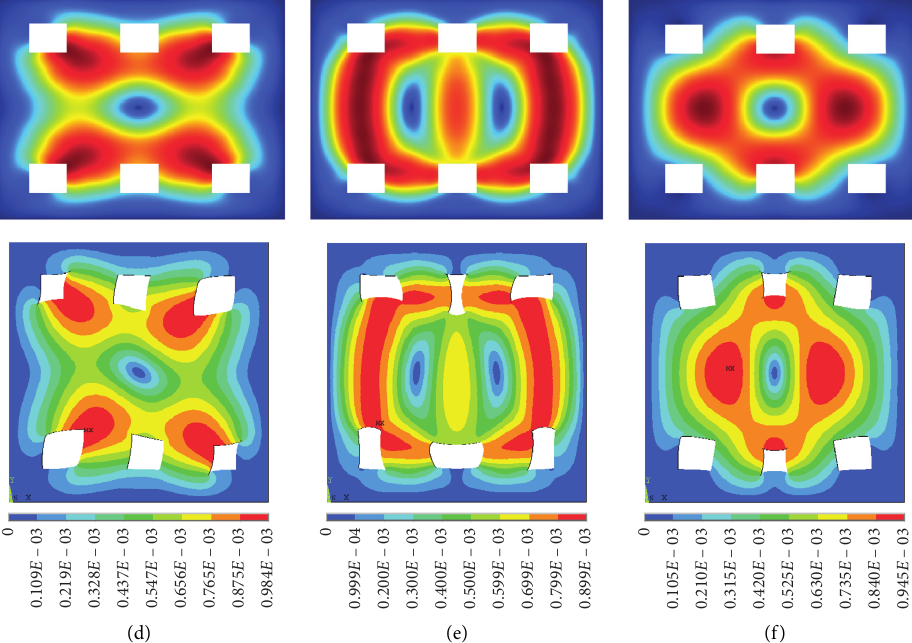
Figure 4: The first six mode shapes for the square plate with six cutouts. (a) The first mode; (b) the second mode; (c) the third mode; (d) the fourth mode; (e) the fifth mode; (f) the sixth mode. Upper: the present results; lower: the ANSYS